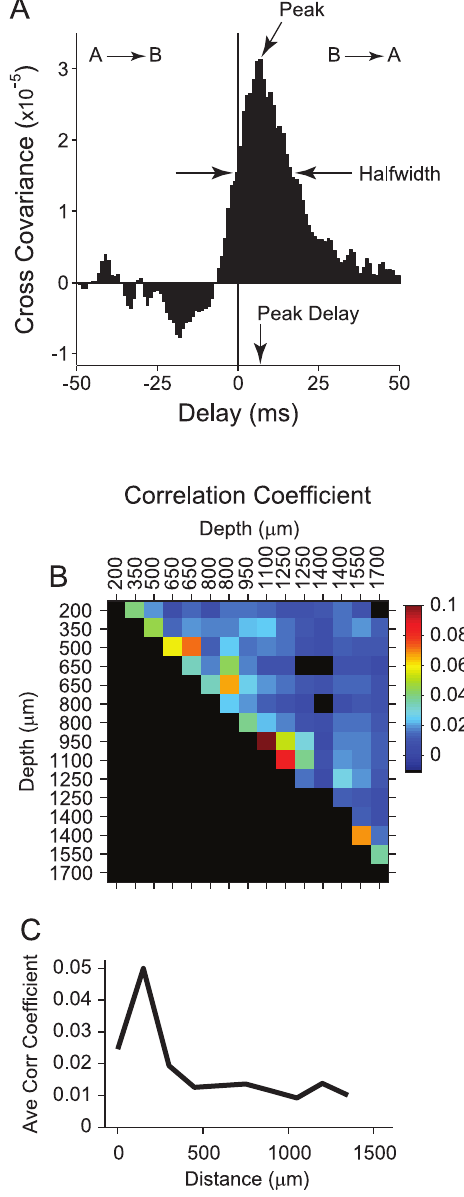
Figure 3. Analysis of cross-covariance functions. (A) Peak value, delay at which the peak occurs, and cross-covariance function halfwidth were extracted from each cross-covariance function. Peak delay and halfwidth are calculated with respect to the maximum (Peak) in the function. (B) Correlation coefficient depth matrix, calculated from cross- covariance functions for the data in Fig. 1. Since the matrix is symmetric, values below the diagonal are not shown. Black squares above the diagonal indicate non-significant connections. Duplicated depth values represent neurons recorded at the same depth. (C) Correlation coefficient versus distance between neurons for the data in (B).